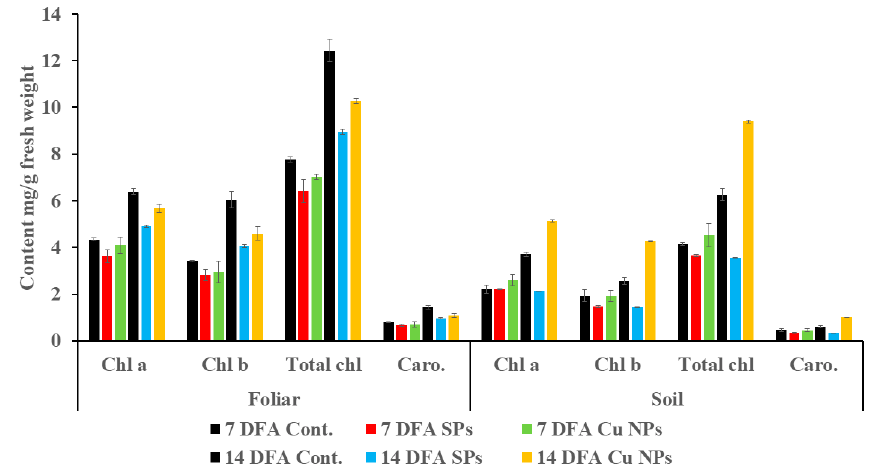
Figure 5. Contents of chlorophyll and carotenoids (mg / g fresh weight) of wheat seedlings treated by 0.06 mg / L of SPs and Cu NPs after 7 and 14 days from foliar and soil applications. The black bar indicates the control for each measured parameter.